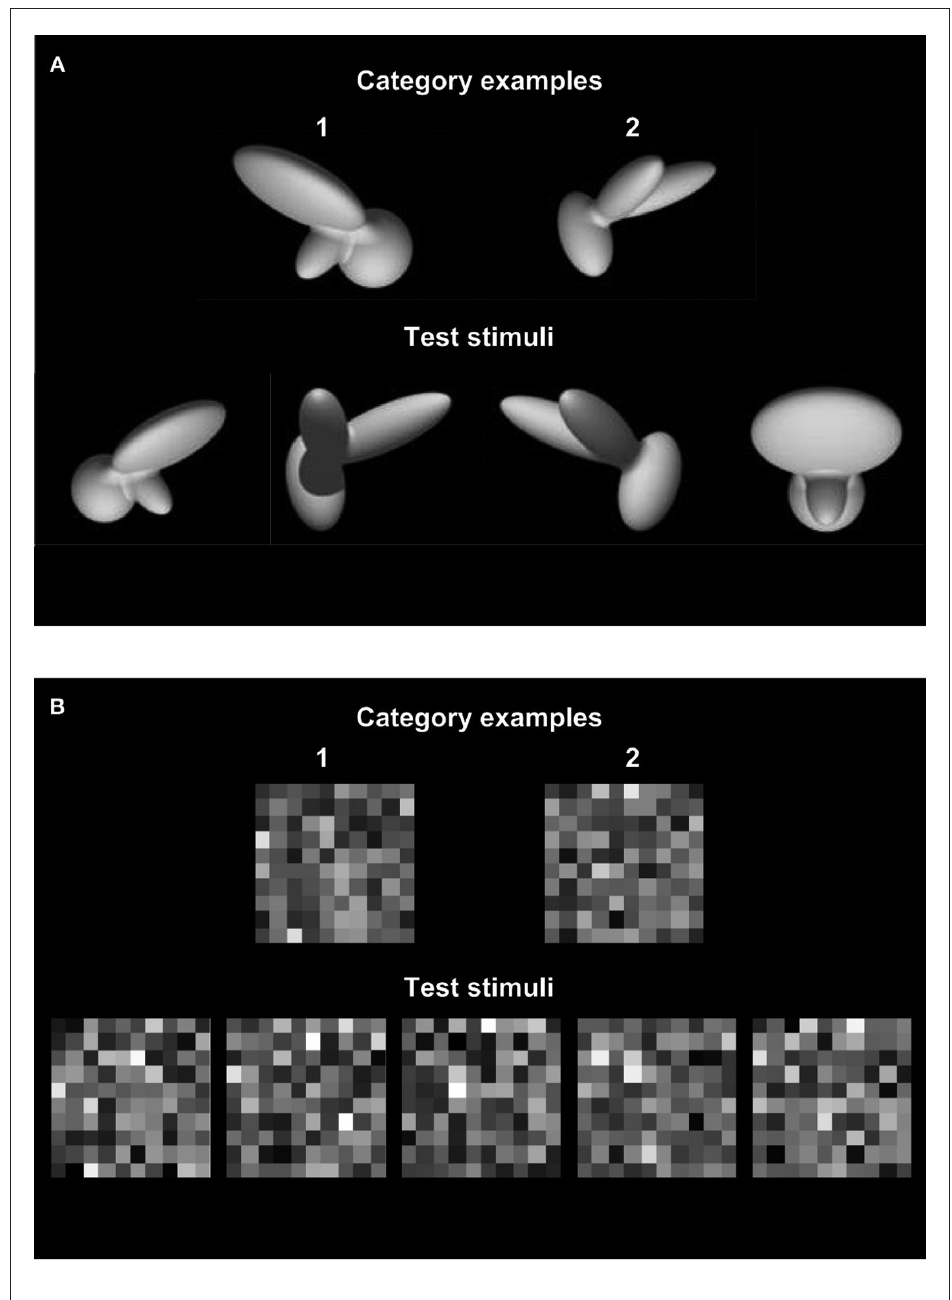
Figure 1 | Examples of invariant and non-invariant object recognition. (A) Single exemplars of two categories (‘1’ and ‘2’; stimuli taken from Zoccolan et al., 2009) are shown in the upper row. When asked to classify unknown instances of these new visual objects (bottom row), human observers solve this problem effortlessly and “see” that the right answer is ‘1, 2, 2, 1’. This is remarkable, given that an ideal observer having access to all available image information, but lacking knowledge of image formation and geometrical transformations, cannot perform this task correctly. Such an ideal observer bases classification on a pixel-by-pixel comparison (Green and Swets, 1966) and judges the test stimuli depicted in the bottom row to belong to category ‘2, 2, 1, 1’, respectively. (B) The tolerance for irrelevant variations in object appearance that is achieved by the human visual system is limited to “natural” irrelevant dimensions such as position, light and context. Although the task portrayed here is much simpler from a computational perspective and trivially easy for the ideal observer, most readers will find it very hard to ignore the irrelevant variations, i.e., weak random perturbations of the exact luminance levels of the category exemplars, and see that the patterns in the lower row belong to category ‘1, 1, 2, 1, 2’,